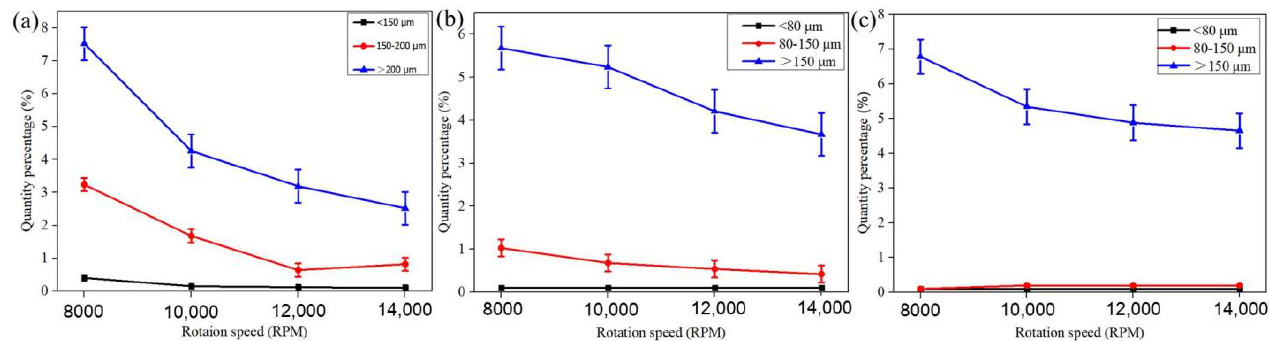
Figure 9. Quantity percentage of powder with pores in PREP powders as a function of particle size range and rotation speed. ( a ) Ti-6Al-4V, ( b ) Co-Cr-Mo, ( c ) 316L.